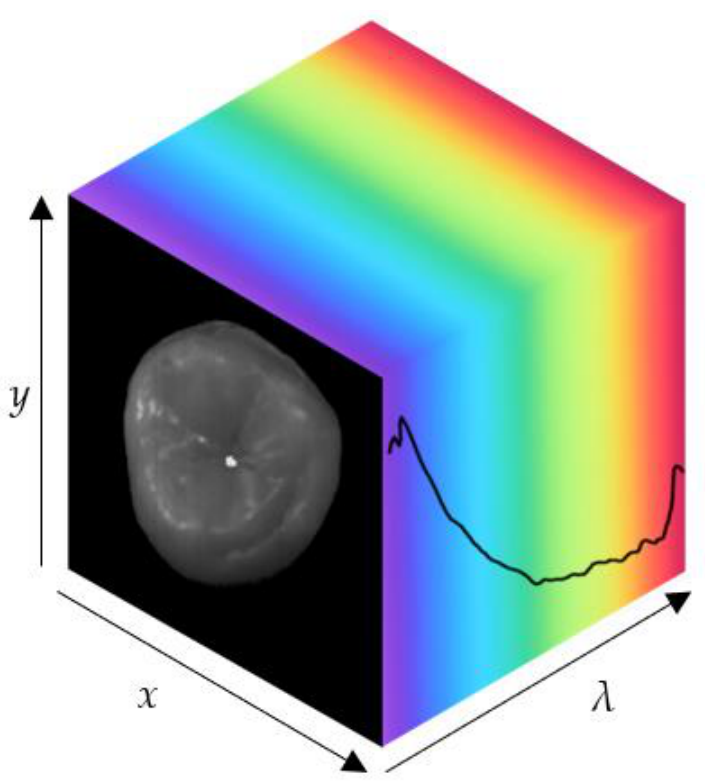
Scheme 1. Hyperspectral imaging captures both spatial (morphological) and spectral (chemical) in- formation. A two-dimensional image is taken, and for each pixel a spectrum is captured as the